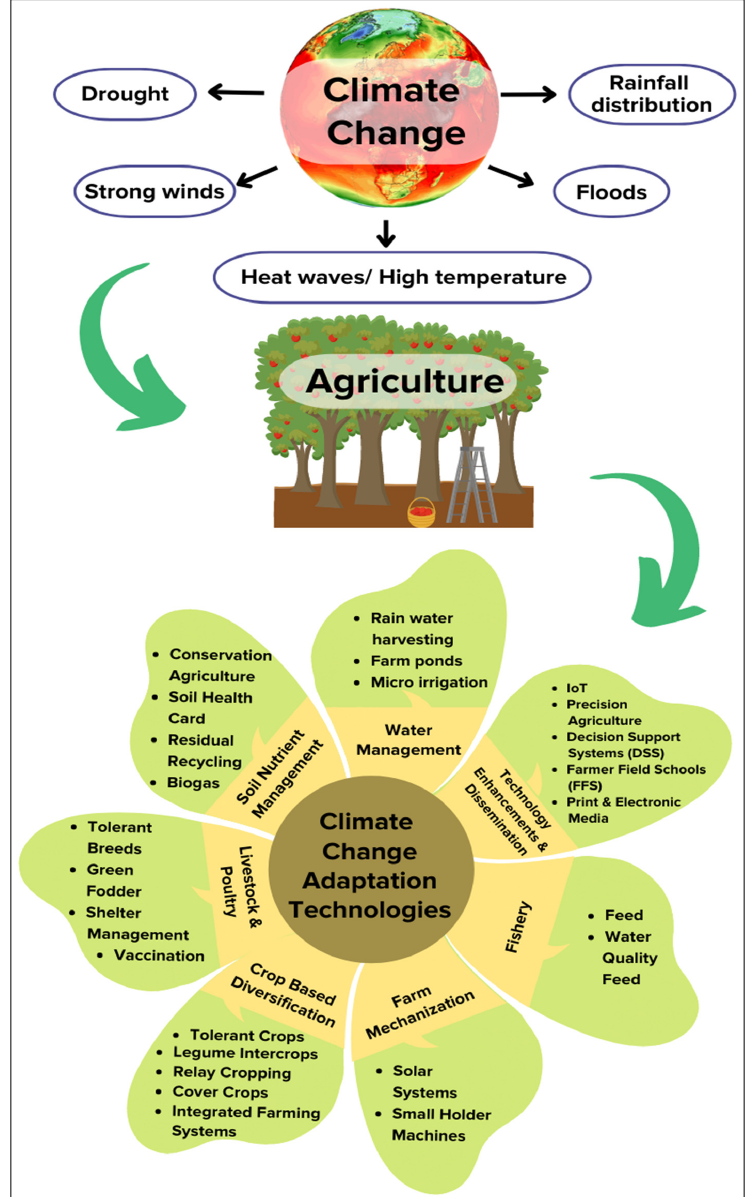
Figure 3. Climatic impacts on agriculture and adaptation technologies to combat climate change.